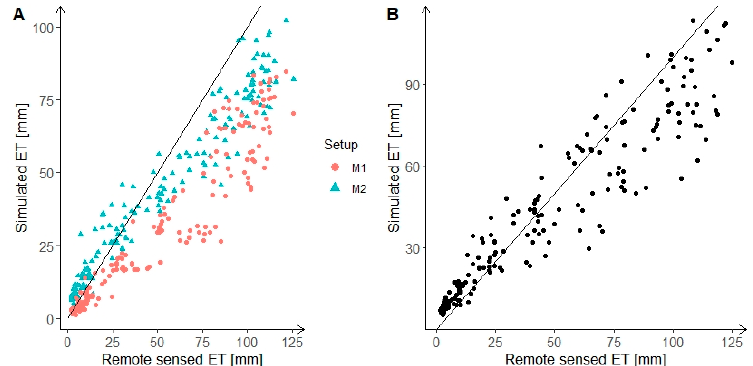
Figure 3. Scatter plot for simulated and remote sensed monthly ET for the years 2001–2015 in the Melk catchment ( A ) and Zaya catchment ( B ). The black line is the reference line with slope 1.